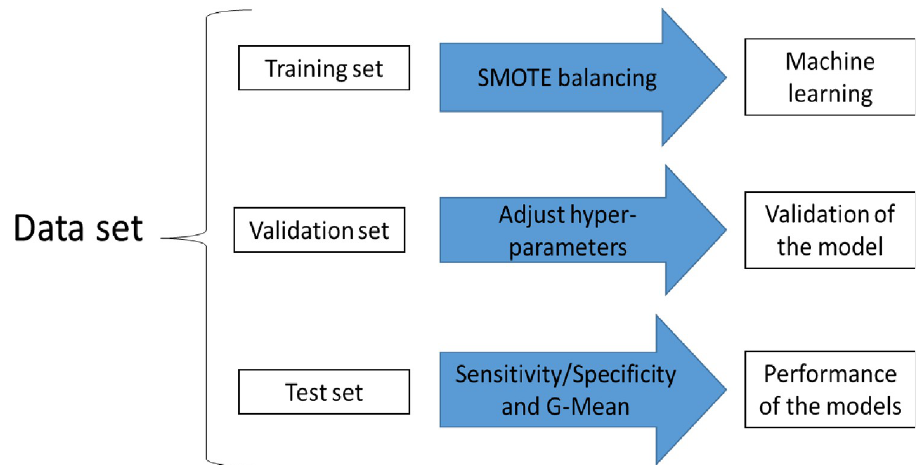
Fig 1. Flowchart of the process of selecting predictor variables based on cross-validation analysis for predicting death among patients with CD within two years of follow-up.